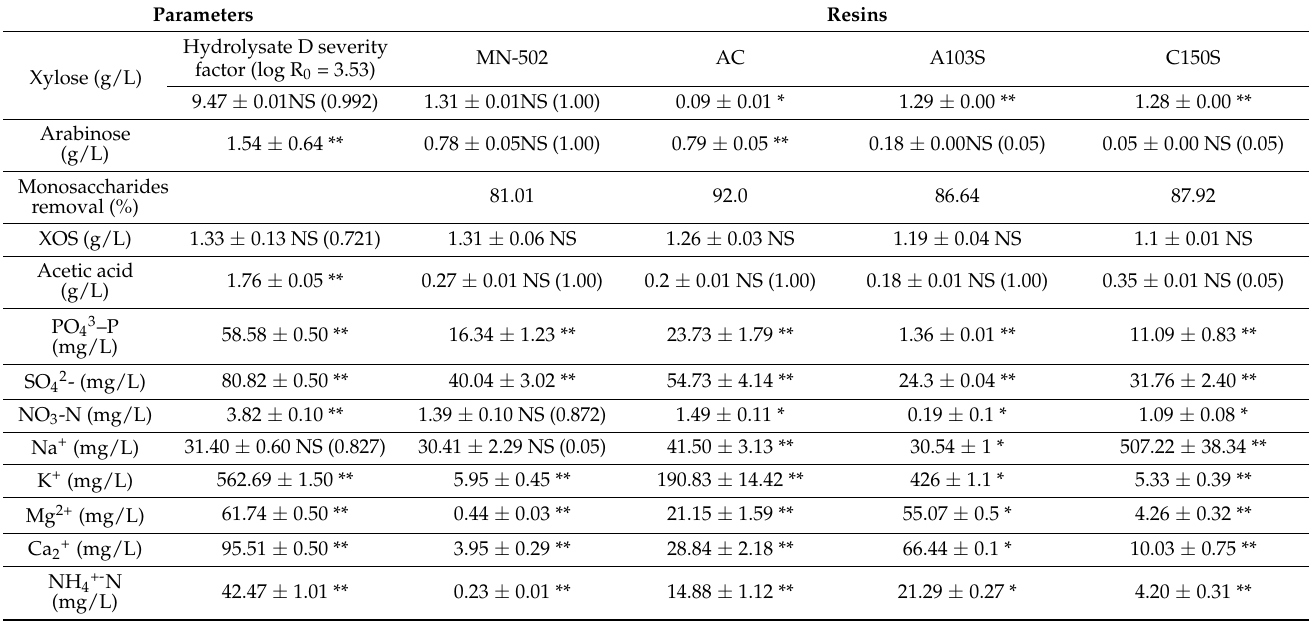
Table 5. Overview of the down-stream processing experiments of 1 L of hydrolysate after alkaline and enzymatic treatment of the residues treated at the highest severity factor (3.53).